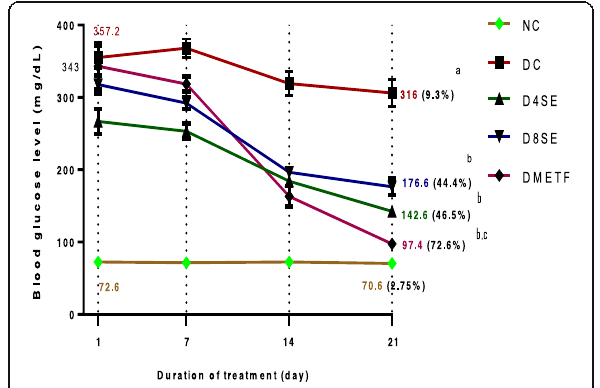
Fig. 3 Curative effect of SE and METF on Blood glucose concentration of STZ-Treated rats. Values are expressed as mean±SEM of 8 rats. Figures in parentheses represent mean percentage reduction in fasting blood glucose. NC =Normal control, DC=Diabetic control, D4SE= Diabetic animals treated with SE (400 mg\kg BW), D8SE=Diabetic animals treated with SE (800 mg\kg BW), DMETF=Diabetic animals treated with metformin (12 mg\kg BW). a=significant when compared to NC, b =significant when compared to DC, c=significant when